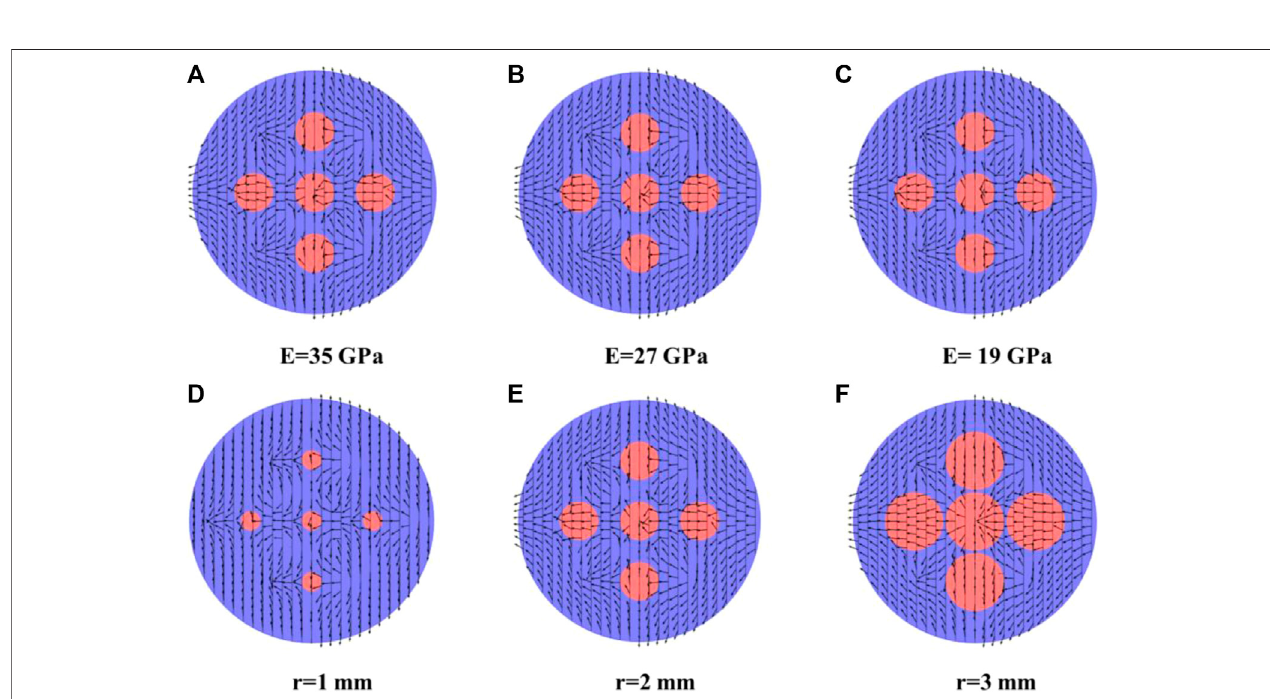
Frontiers in Earth Science |